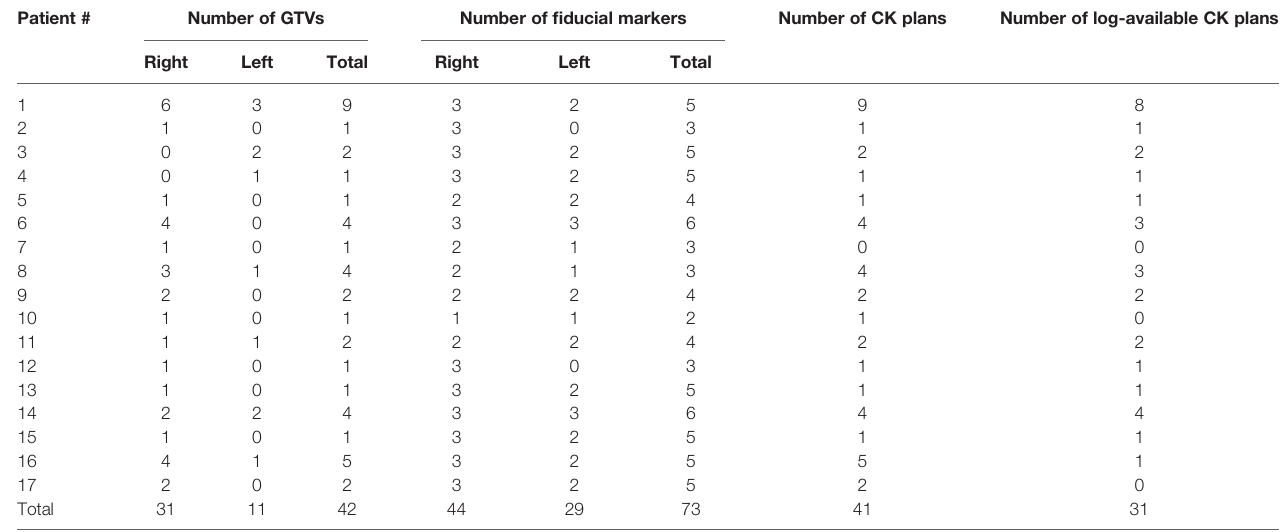
TABLE 1 | Summary of patient